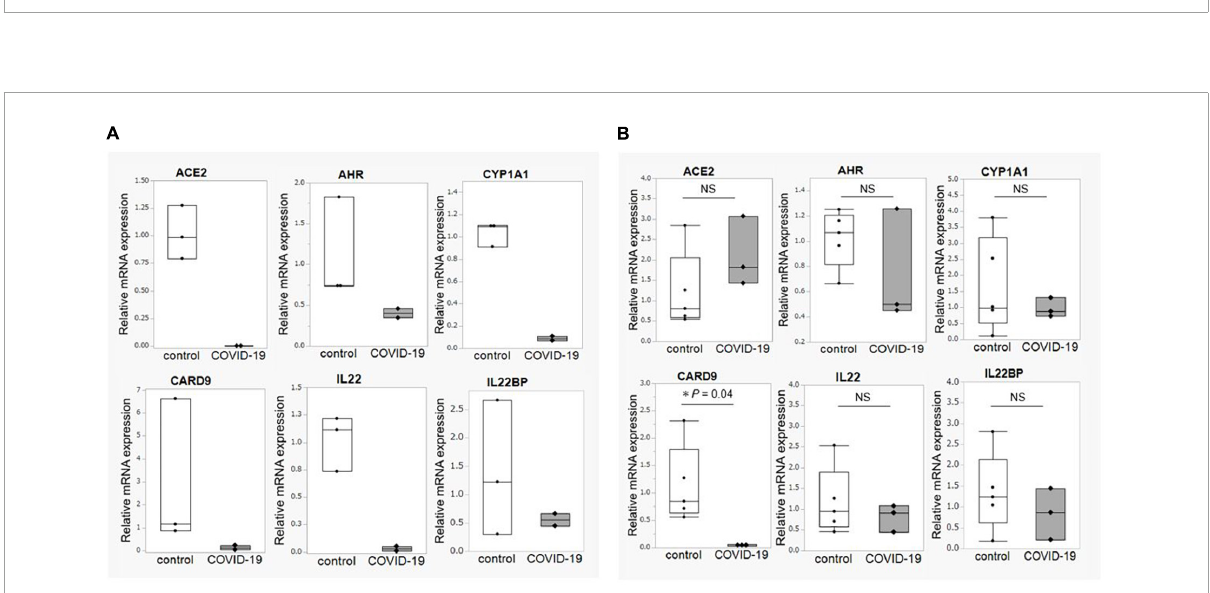
FIGURE5 Intestinal mucosal gene expression associated with tryptophan metabolism. (A) Comparison of gene expression associated with tryptophan metabolism between COVID-19 patients ( n = 2) and healthy controls ( n = 3) in the ileum. (B) Comparison of gene expression associated with tryptophan metabolism between COVID-19 patients ( n = 3) and healthy controls ( n = 5) in the colon. Statistical analysis was performed using the Wilcoxon rank sum-test. Statistical significance was accepted as P < 0.05. NS means P > 0.05. ACE2, angiotensin-converting enzyme-2; AHR, aryl hydrocarbon receptor; CYP1A1, Cytochrome P450 1A1; CARD9, caspase recruitment domain-containing protein